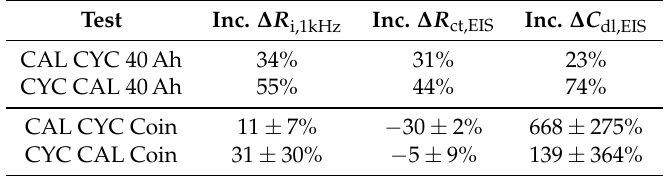
Table 10. Development of the cell resistances R i and R ct and of the double-layer capacitance C dl based on EIS measurements of the 40Ah cells and the coin cells after sequential calendar and cyclic aging (CAL CYC) and vice versa (CYC CAL). Inc: increase.